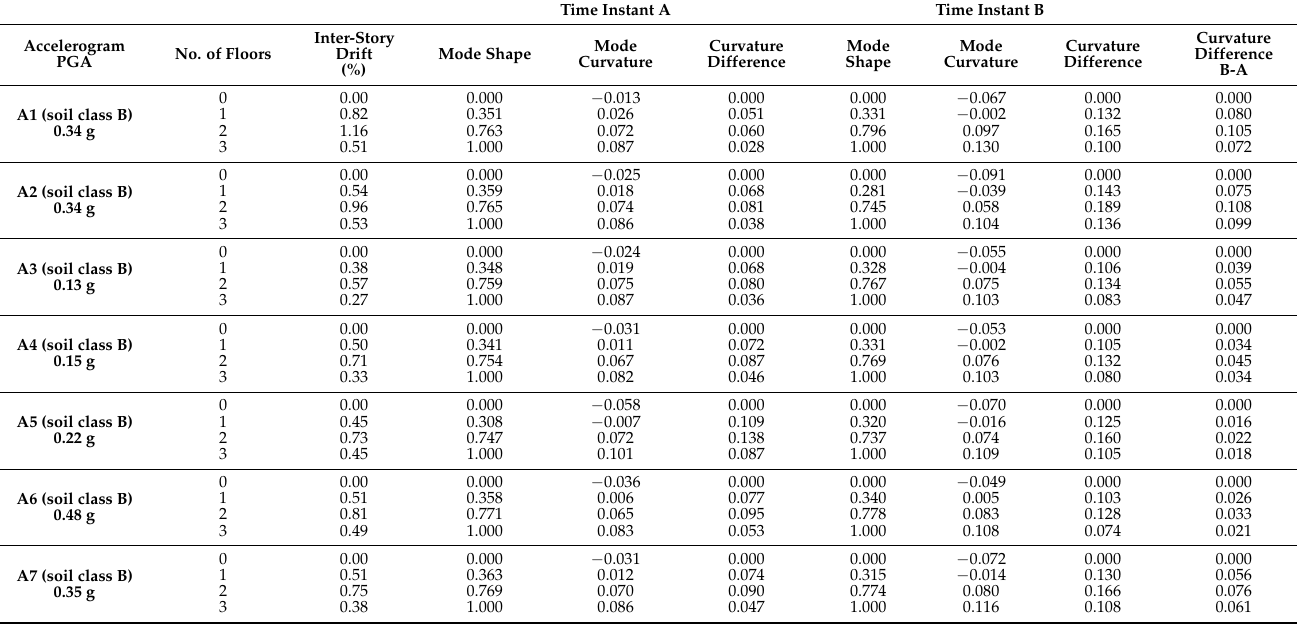
Table A1. Values of the main parameters evaluated for the 3-story numerical model in correspondence to the fundamental mode of vibration.